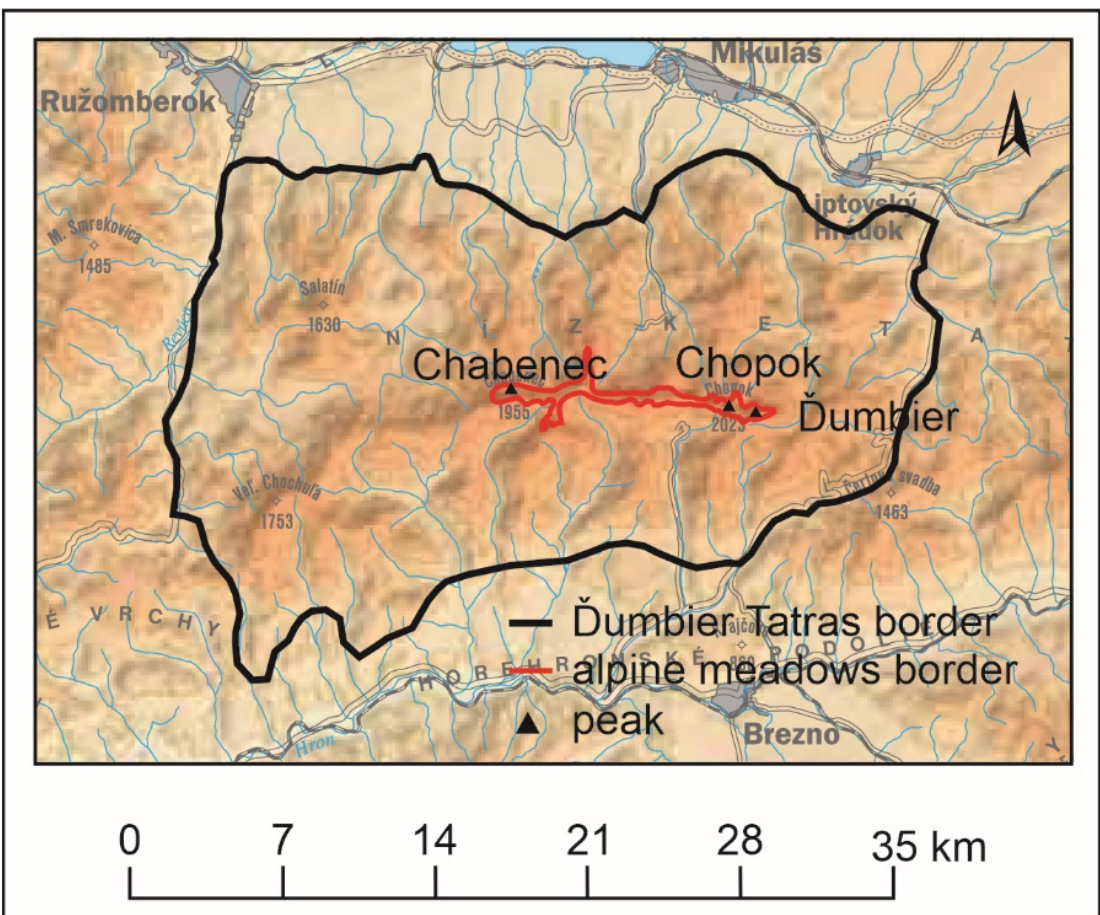
Figure 6. The area of natural alpine meadows in the Ď umbier Tatras was only 941.66 ha. Source: National Atlas of Slovak Republic, 2002 (Map: Potential natural vegetation).